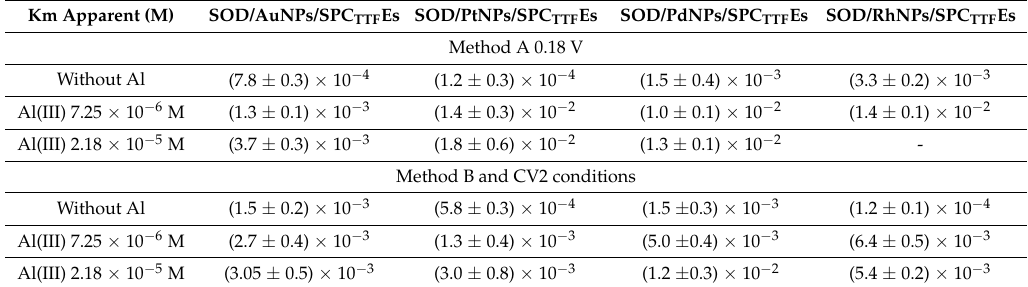
Table 4. Km apparent values for SPC TTF Es modified with AuNPs, PtNPs, RhNPs, and PdNPs.